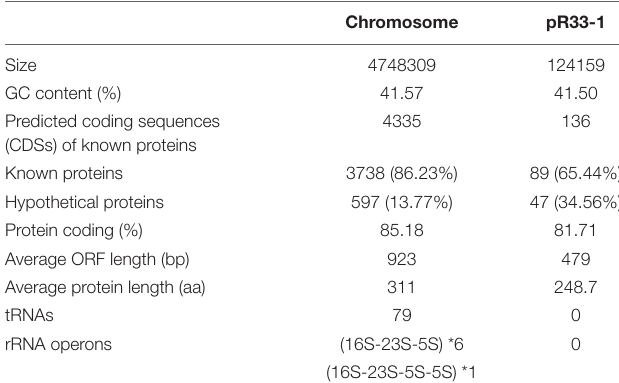
( Table 3 and Figure 1 ), and a circular plasmid designated pR33- 1, which is 124,159 bp in length and encodes 136 ORFs ( Table 3 ). According to genome sequencing, only three chromosomal genes with a similarity of ≥ 80% with housekeeping genes, namely, crp (encoding cAMP-receptor protein), rsmA (encoding translational regulator CsrA), and E. coli gyrA (encoding DNA gyrase subunit A) (with similarities of 97.6%, 86.89%, and 83.72%, respectively), were identified. No predicted aminoglycoside resistance genes with similarity ≥ 80% were found. Among all 11 predicted aminoglycoside resistance-related genes (with similarity < 80%) annotated from the whole genome, only one predicted AAC gene